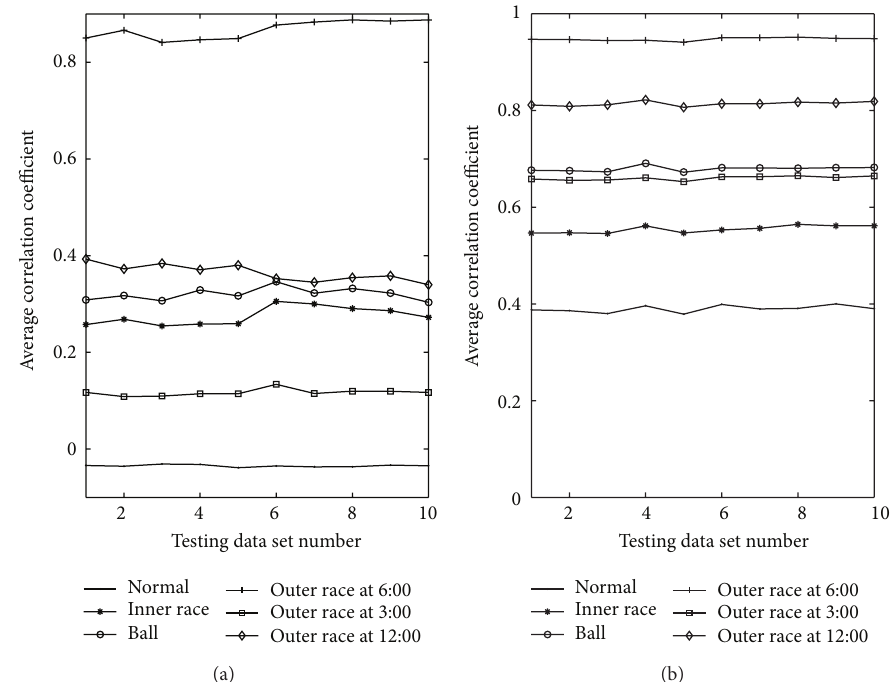
Figure 7: Detection results of data set A with an outer fault located at 6:00 according to morphology spectrum correlation analysis: (a) signal based triangular SE; (b) flat